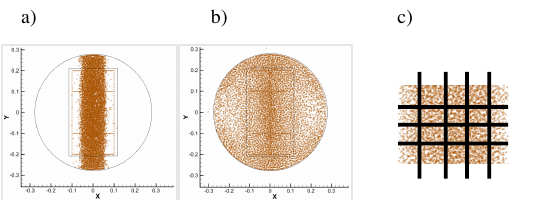
Fig. 5. Simulation snapshots showing hopper discharge in a petridish (side view), a) at time t = 0s, b) at t = 3s and c) at t = 5s, d) snapshot of the particle packing at the end of the simulation